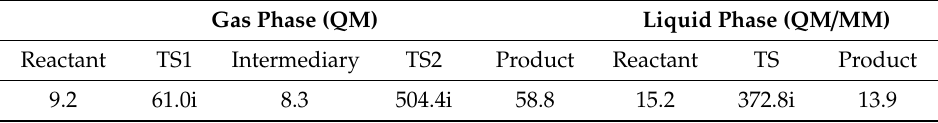
Table 3. First harmonic frequency (in cm − 1 ) of all structures reported in the mechanism of the reaction in gas phase and liquid